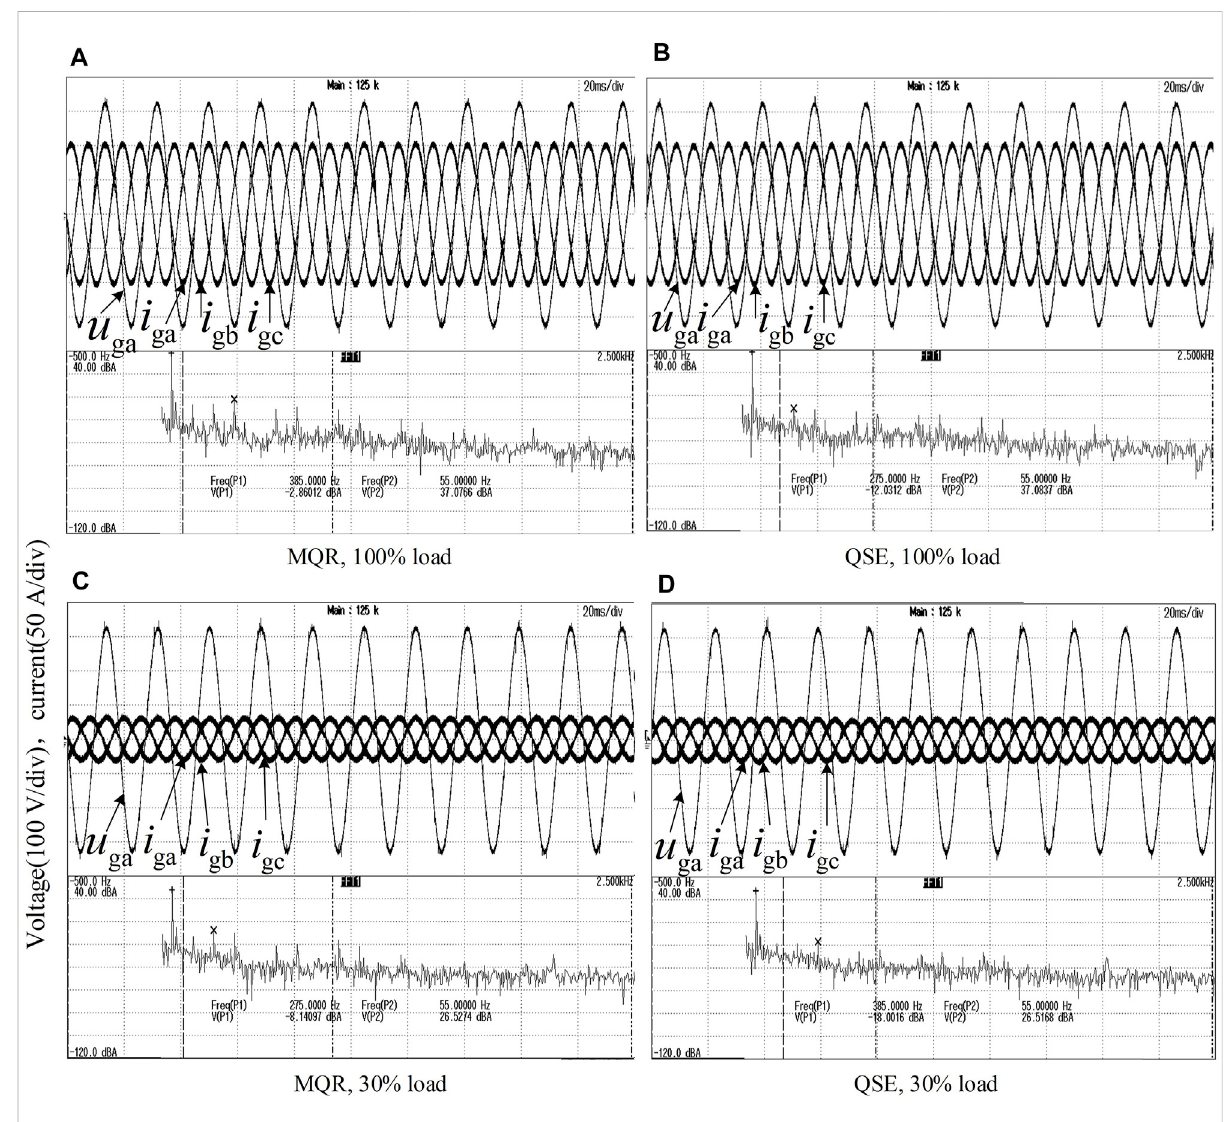
FIGURE 9 Experimental results at 55 Hz